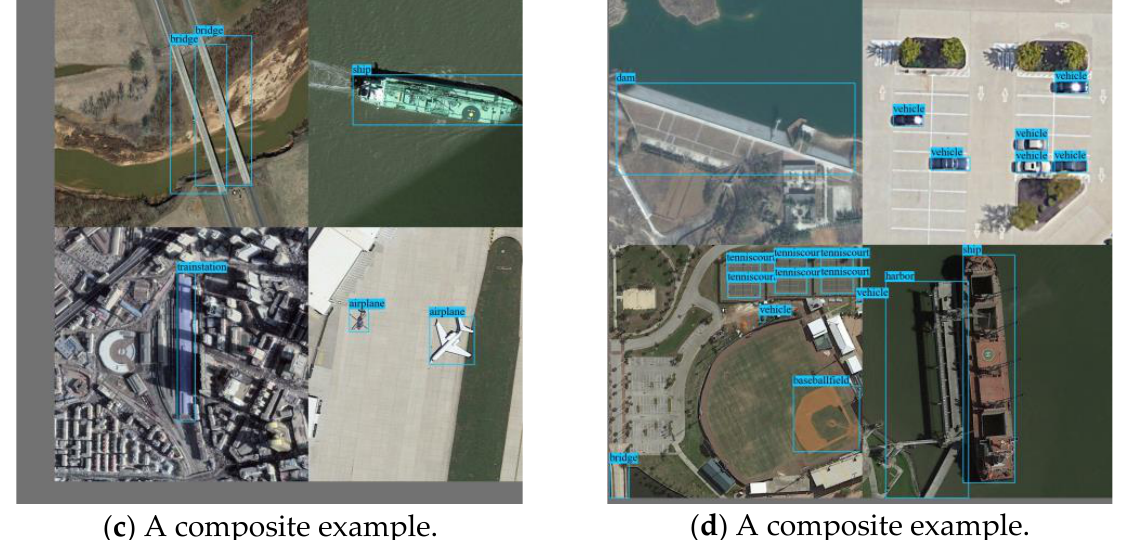
Figure 5. Several examples of composite samples for RSI object detection. The samples are from the DIOR data set, whose size is 800 × 800 , and their spatial resolutions are between 30 m and 0.5 m. The size of composite images is set at 1600 × 1600 .